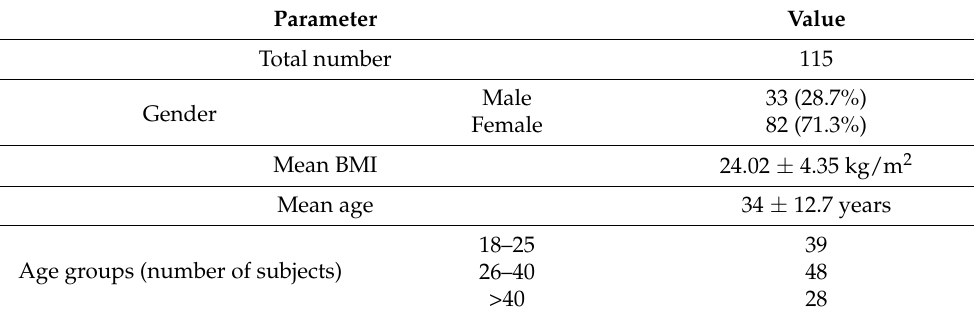
Table 1. Descriptive data of the healthy subjects with ViPLUS reliable